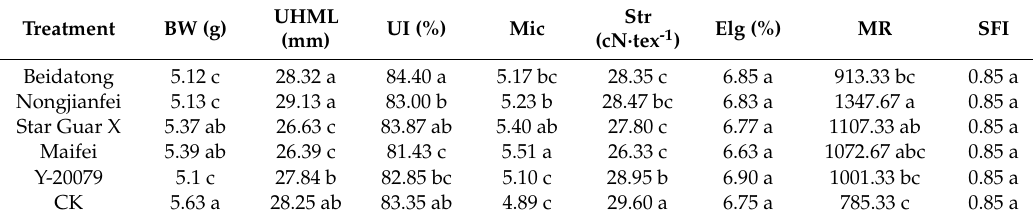
Table 7. E ff ect of aviation spray adjuvants on cotton fiber quality and yield sprayed by UAV.